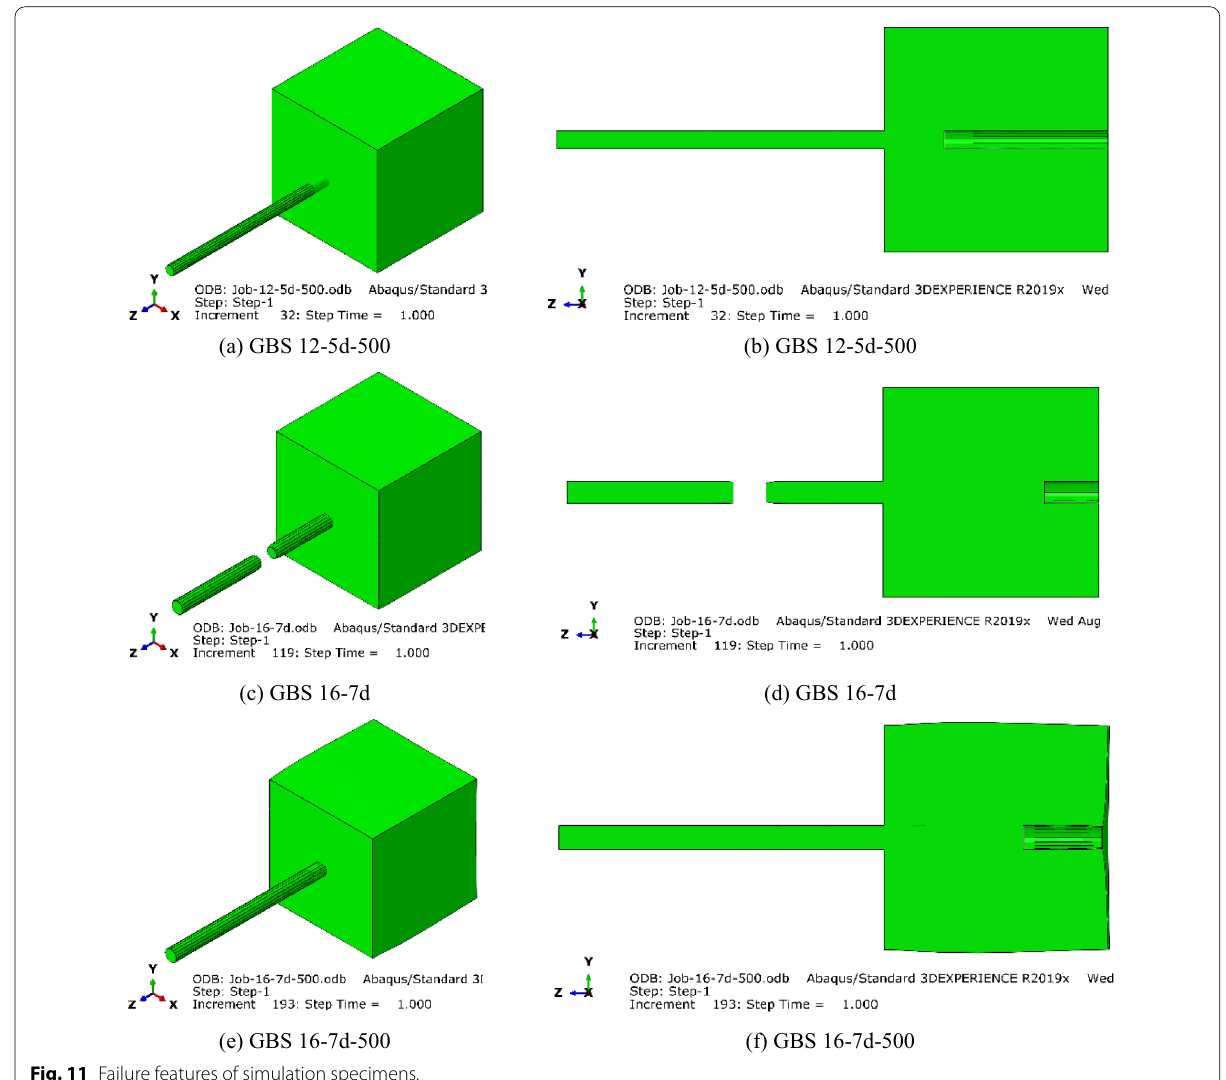
Fig. 11 Failure features of simulation